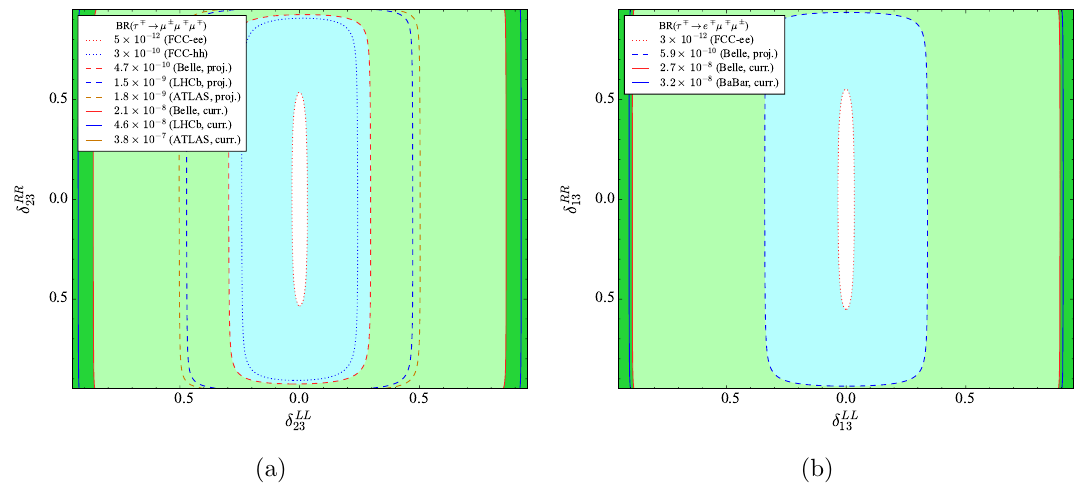
Figure 7. Current and future branching ratio limits in the parameter plane of (a) (cid:14) LL for the decay (cid:28) (cid:7) ! (cid:22) (cid:6) (cid:22) (cid:7) (cid:22) (cid:7) and (b) (cid:14) LL